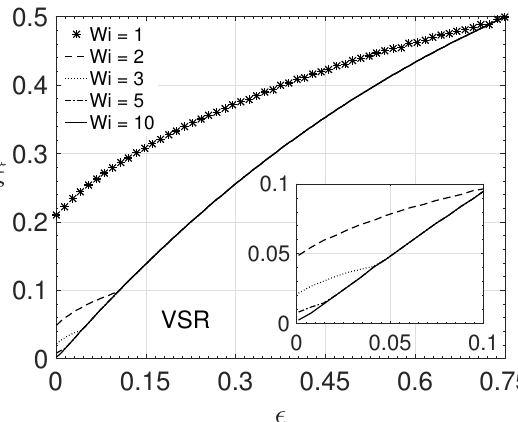
Figure 15. Valid solution region for different Wi values with (cid:101) and ξ - Re = 2000 and β =